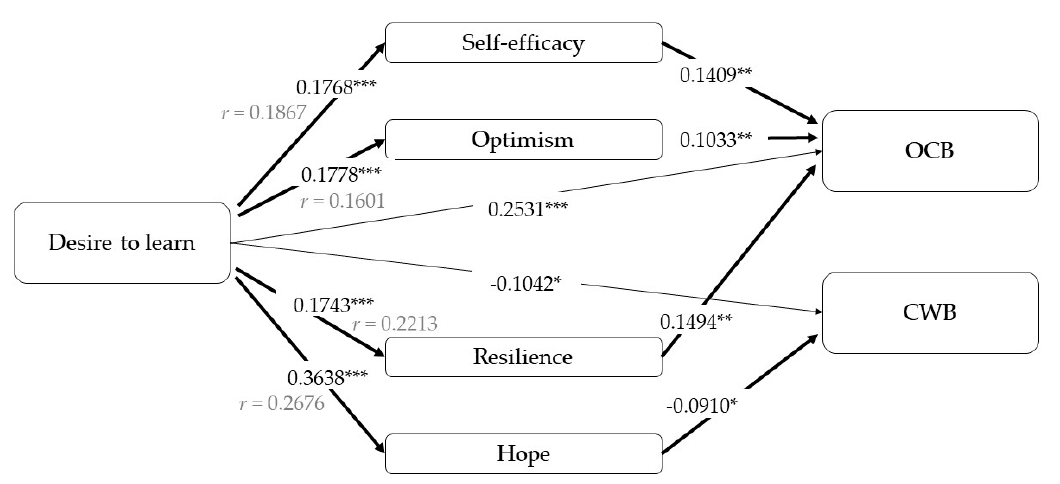
Figure2. Resultsofthemediationmodelswithdesiretolearnasanindependentvariable. Note:[95%CI]; * p < 0.05; ** p < 0.01; *** p < 0.001. Figure 2. Results of the mediation models with desire to learn as an independent variable. Note: [95% CI]; * p < 0.05; ** p < 0.01; *** p < 0.001.